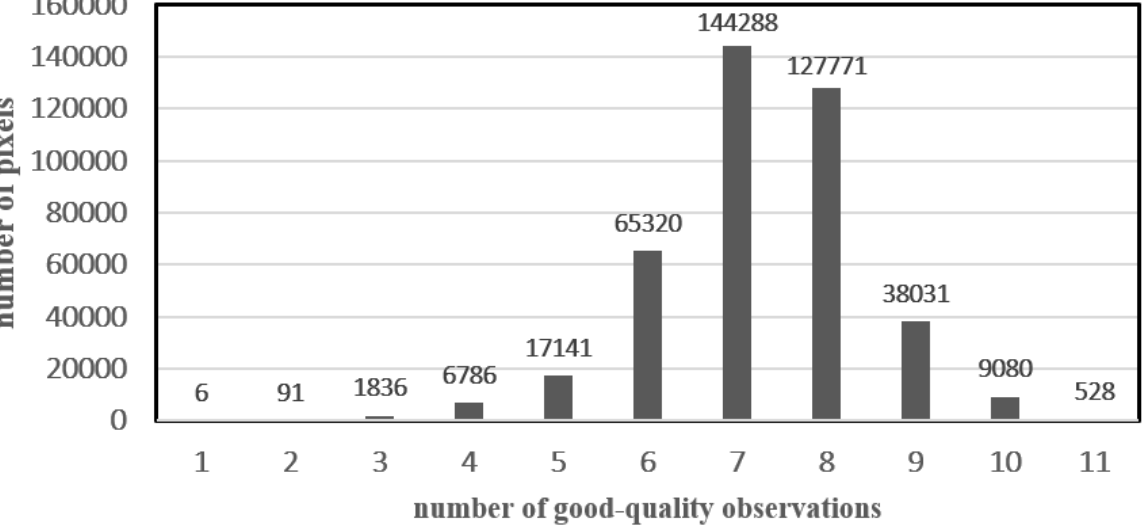
Figure A4. The number of pixels with good-quality observations in 2020.